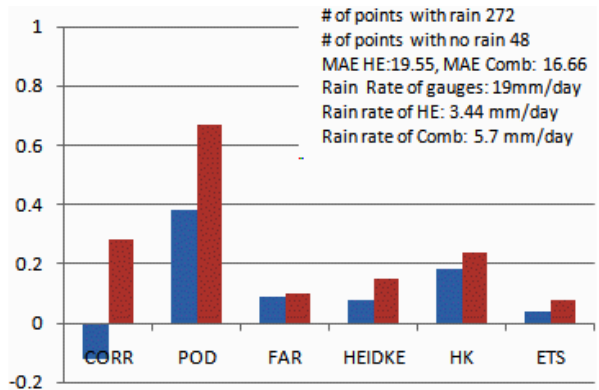
Fig. 15. Statistical evaluation of 17 June 2008 for HE (blue) and COMB (red).